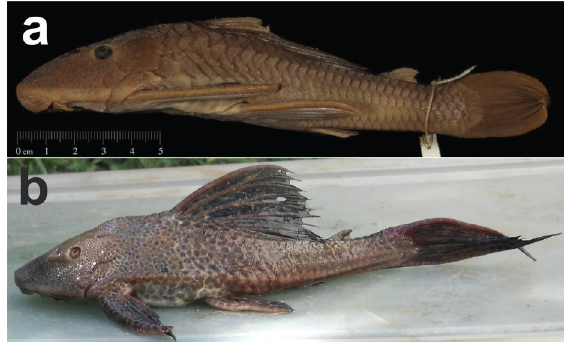
Figure 10 - Hypostomus laplatae : ( a ) paratype, CAS 77342. Dorsal view. (Photograph: California Academy of Sciences, San Francisco); ( b ) live specimen from lower Paraná River, San Pedro, Buenos